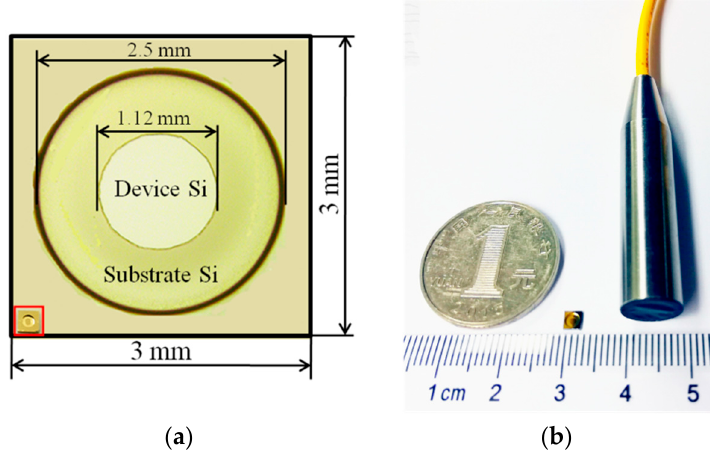
Figure 4. Photographs of ( a ) SOI diaphragm structure and the sensor chip; ( b ) a packaged extrinsic Fabry–Perot interferometric (EFPI) sensor probe.